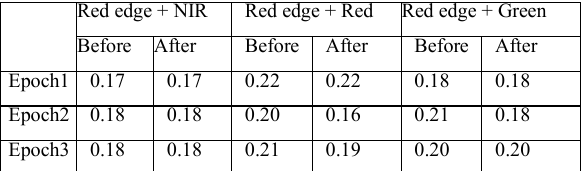
Table 7. PS horizontal positional RMSE (pixels) using